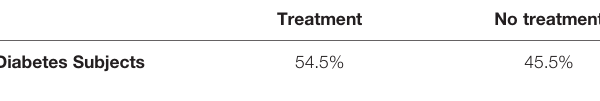
TABLE 4 | Proportion of self-reported diabetes individual prescribed for